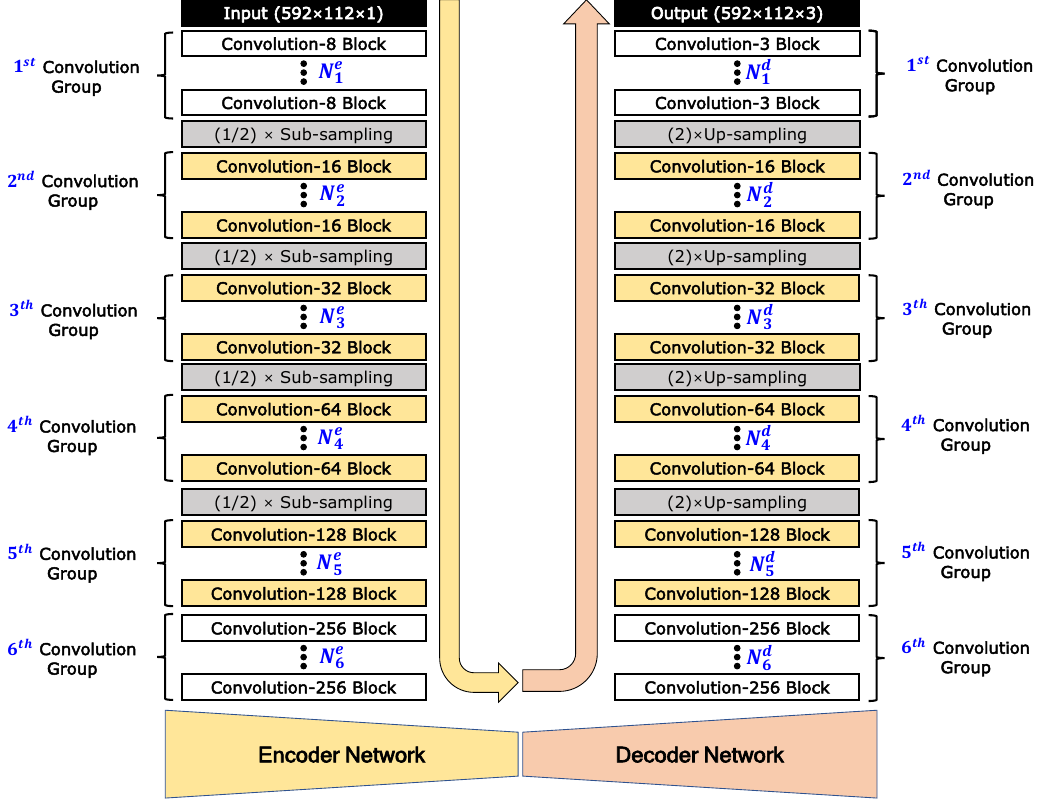
Figure 3. Architecture design of our proposed image-generation network